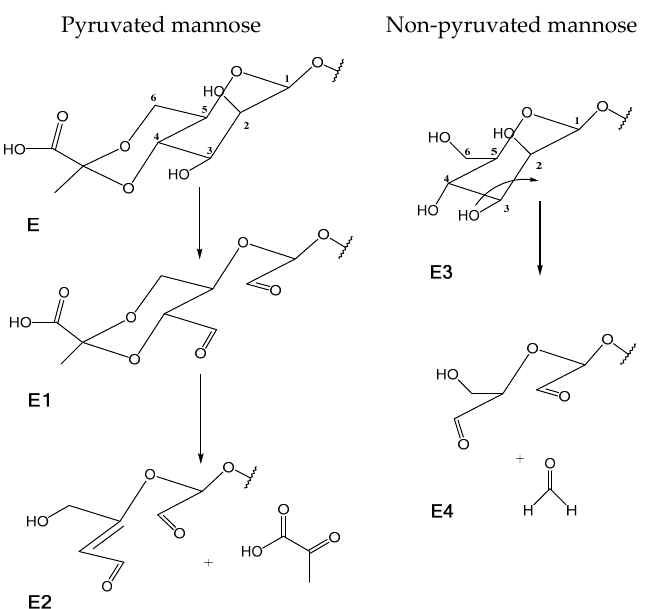
Figure 4. Proposed structures for the terminal mannose unit of the side chain at different stages of oxidation: ( E ) non-oxidized pyruvated mannose; ( E1 ) oxidized pyruvated mannose –C -2 –C -3 cleavage; ( E2 ) loss of pyruvic acid by β -elimination and formation of a double bond between C -4 –C -5 ; ( E3 ) non-oxidized mannose; ( E4 ) oxidized mannose –C -2 –C -4 and loss of C -3 as formaldehyde.